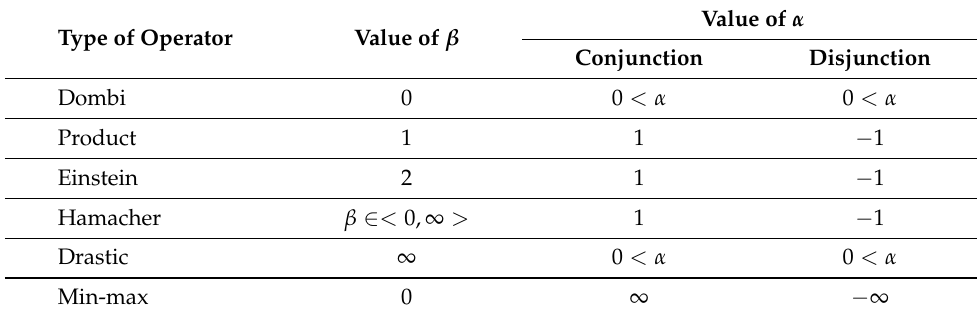
Table 1. Special cases of the generalized Dombi